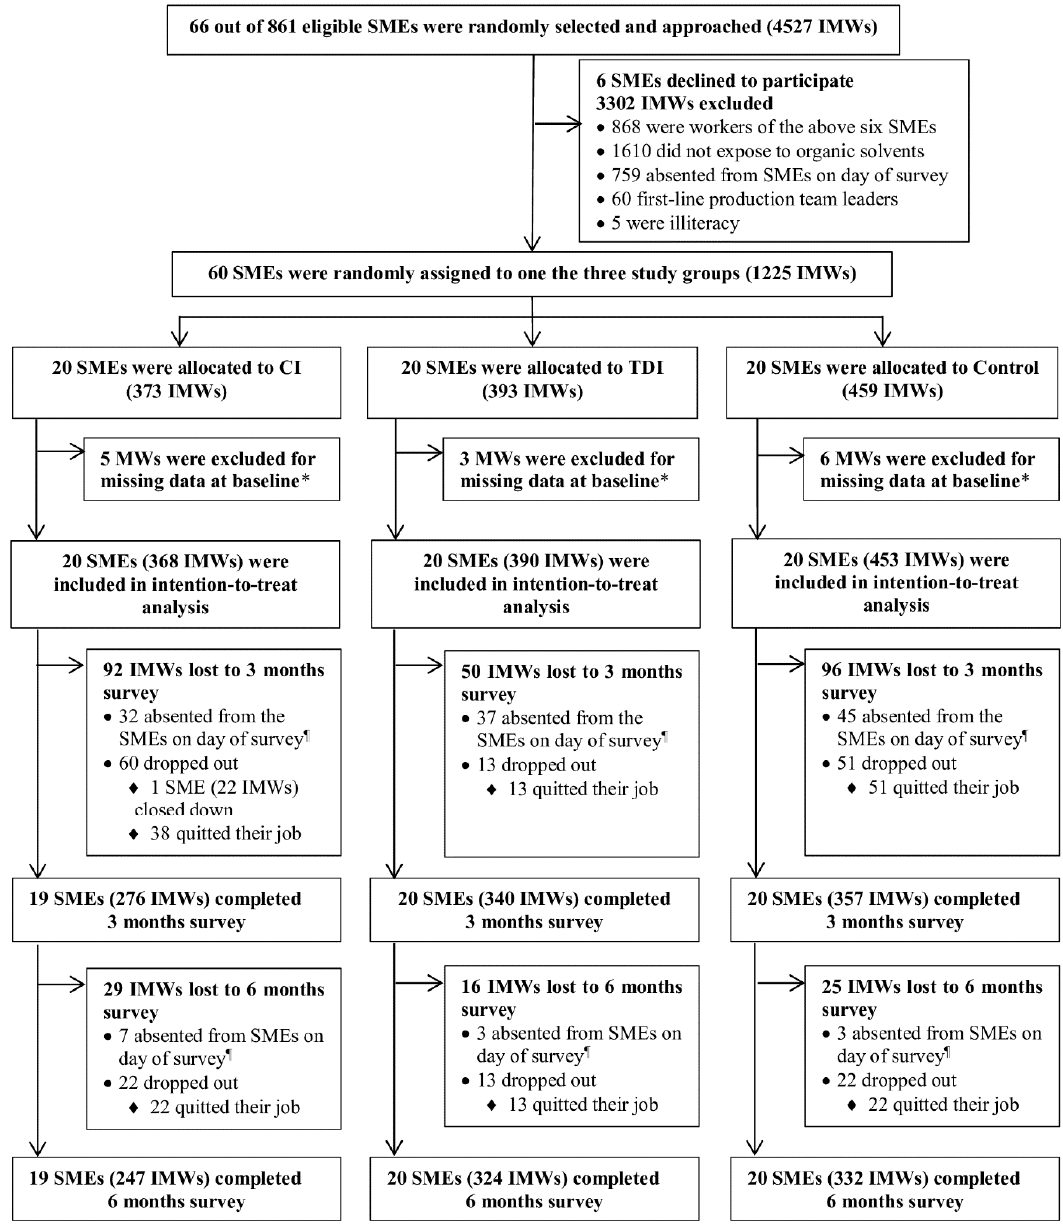
Figure 1. Flow diagram. SMEs = small and medium-sized enterprises; IMWs = internal migrant workers; CI = comprehensive intervention; TDI = top-down intervention. * Internal Migrant workers who had missing data for the primary outcome (effective use of personal protective equipment during the last week) at baseline survey were excluded. ¶ Internal Migrant workers absented from the SME on day of survey because of work shifts or days off.